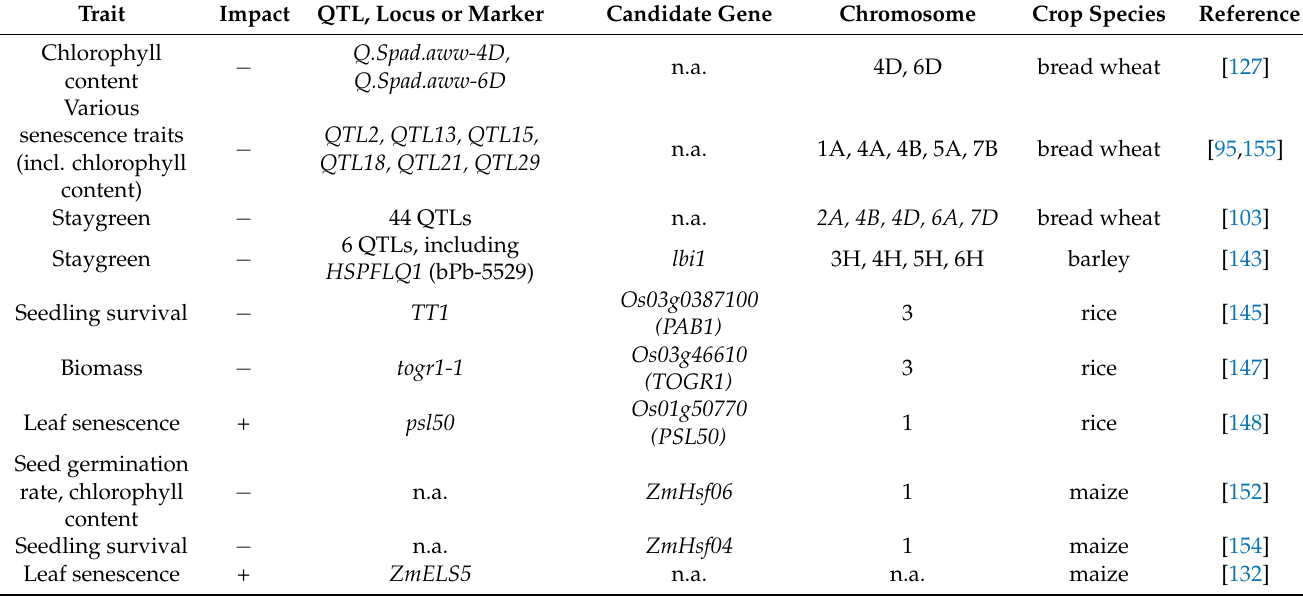
Table 5. Effects of heat on cereal crop senescence and biomass. The ‘+’ sign indicates an increase, and the ‘ − ’ sign shows a decrease in the performance of the trait of interest. n.a.: not